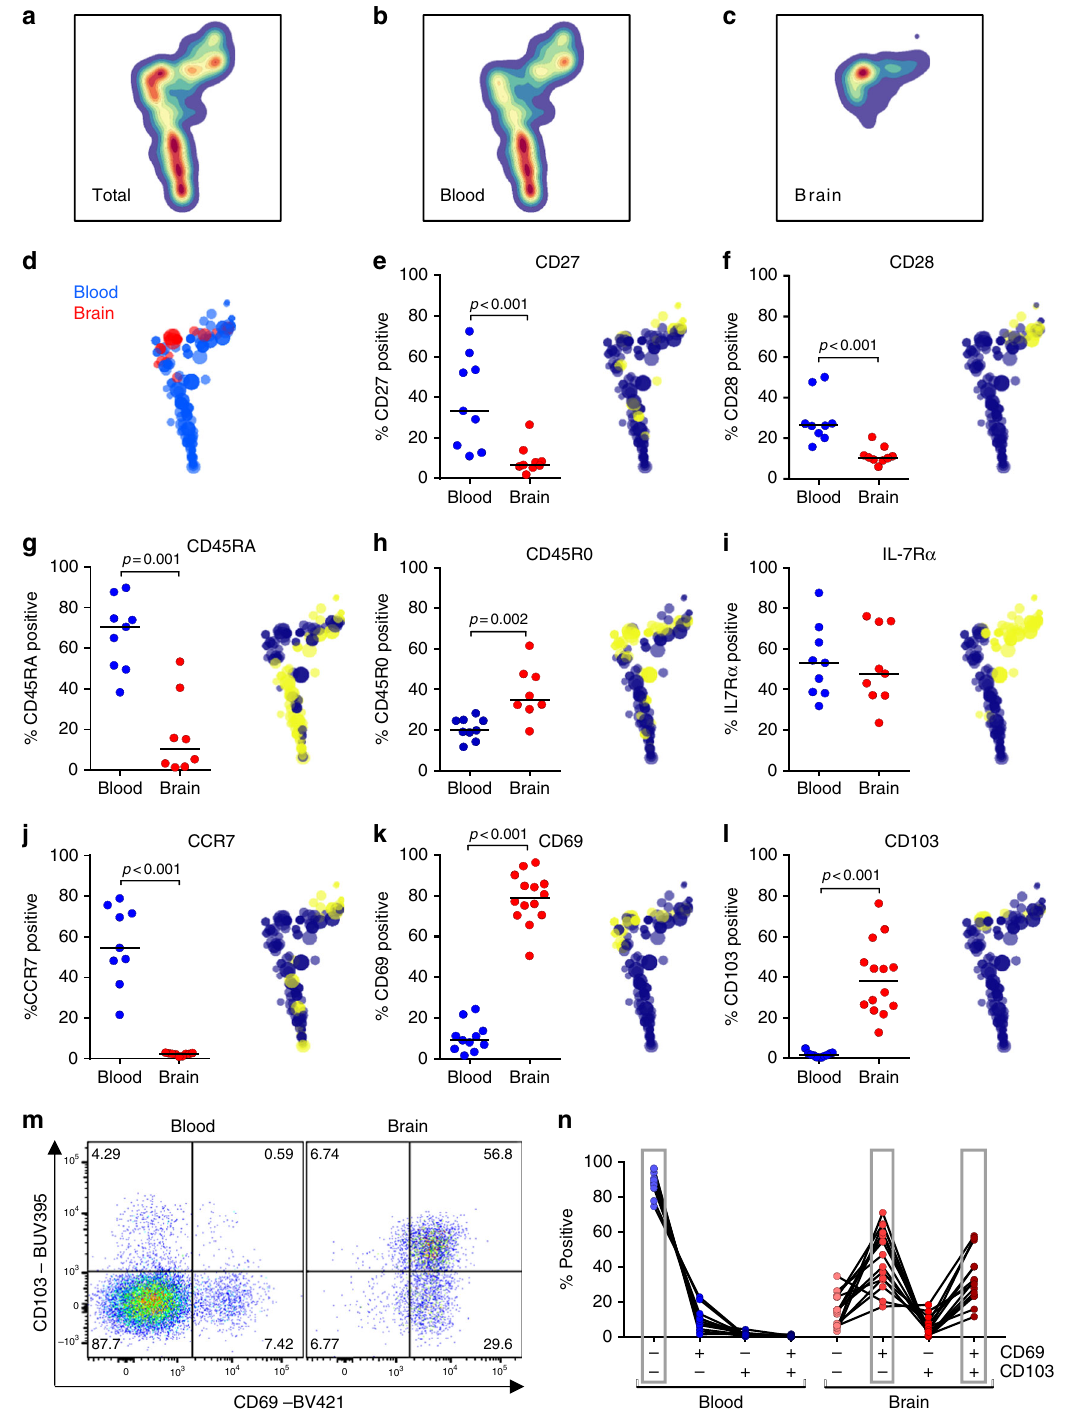
+ ++ – Fig. 2 Human brain CD8 + T cells express the tissue residence markers CD69 and CD103. a – c HSNE plot of paired brain-derived and blood-derived CD8 + T cells of n = 5 donors, based on expression of markers shown in this fi gure, as well as KLRG1 and GPR56, shows segregated clustering of blood-derived and brain-derived CD8 + T cells. d Distribution of hierarchical clusters in the HSNE plot with the size of the dots indicating hierarchical cluster size. e – l Quanti fi cation of CD8 + T cells expressing CD27, CD28, CD45RA, CD45R0, IL-7R α , CCR7, CD69, and CD103, respectively. In the HSNE plots, yellow dots indicate positive and blue dots negative hierarchical clusters. Clustering of brain CD8 + T cells is most prominently characterized by high expression of CD69 and CD103. Bars show median values. p -values show Mann – Whitney U test; no brackets indicate no signi fi cant difference. m Dot plot of CD69 and CD103 co-expression in CD3 + CD8 + T cells eluted from blood and brain. n Co-expression of CD69 and CD103. The dominant phenotype was CD69 − CD103 − in blood and CD69 + CD103 − and CD69 + CD103 + in